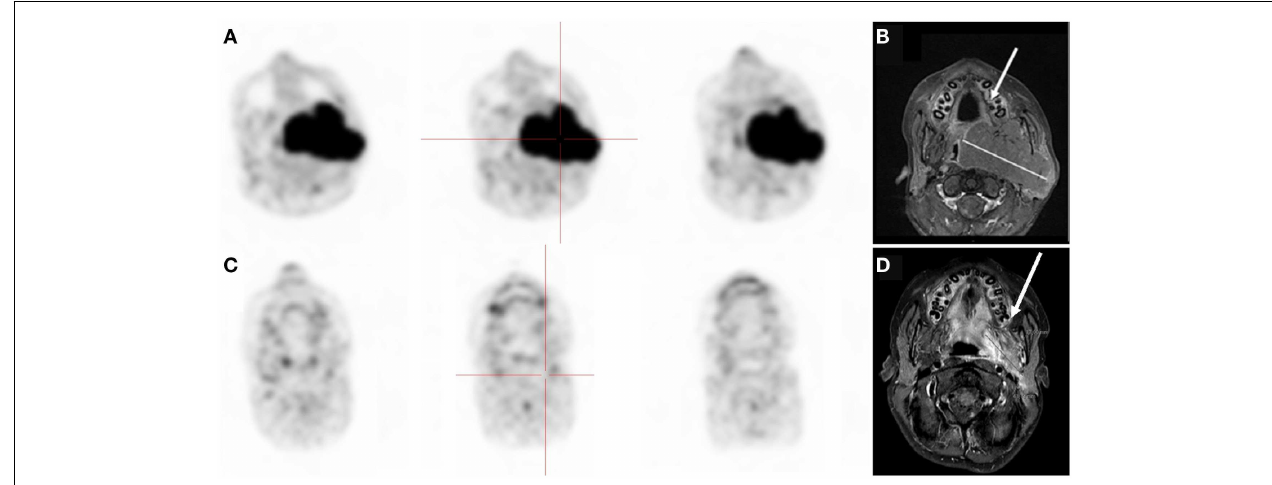
FIGURE 1 |Thirteen-year-old boy with stage III Burkitt’s lymphoma . (A,B) 18 FDG-PET and MRI at diagnosis showing oropharynx tumor. (C,D) Negative 18 FDG-PET but residual disease on MRI after chemotherapy. Biopsy of the residual mass was